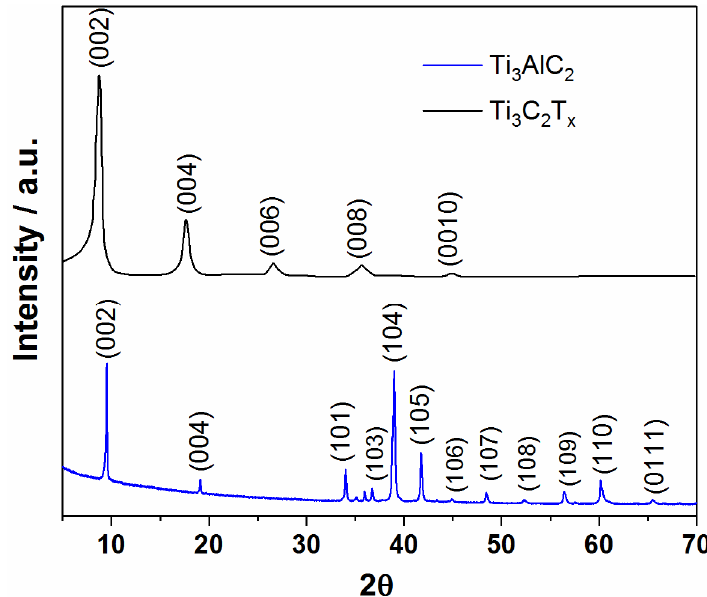
Figure 2. XRD patterns of Ti 3 AlC 2 MAX phase and Ti 3 C 2 T x MXene.